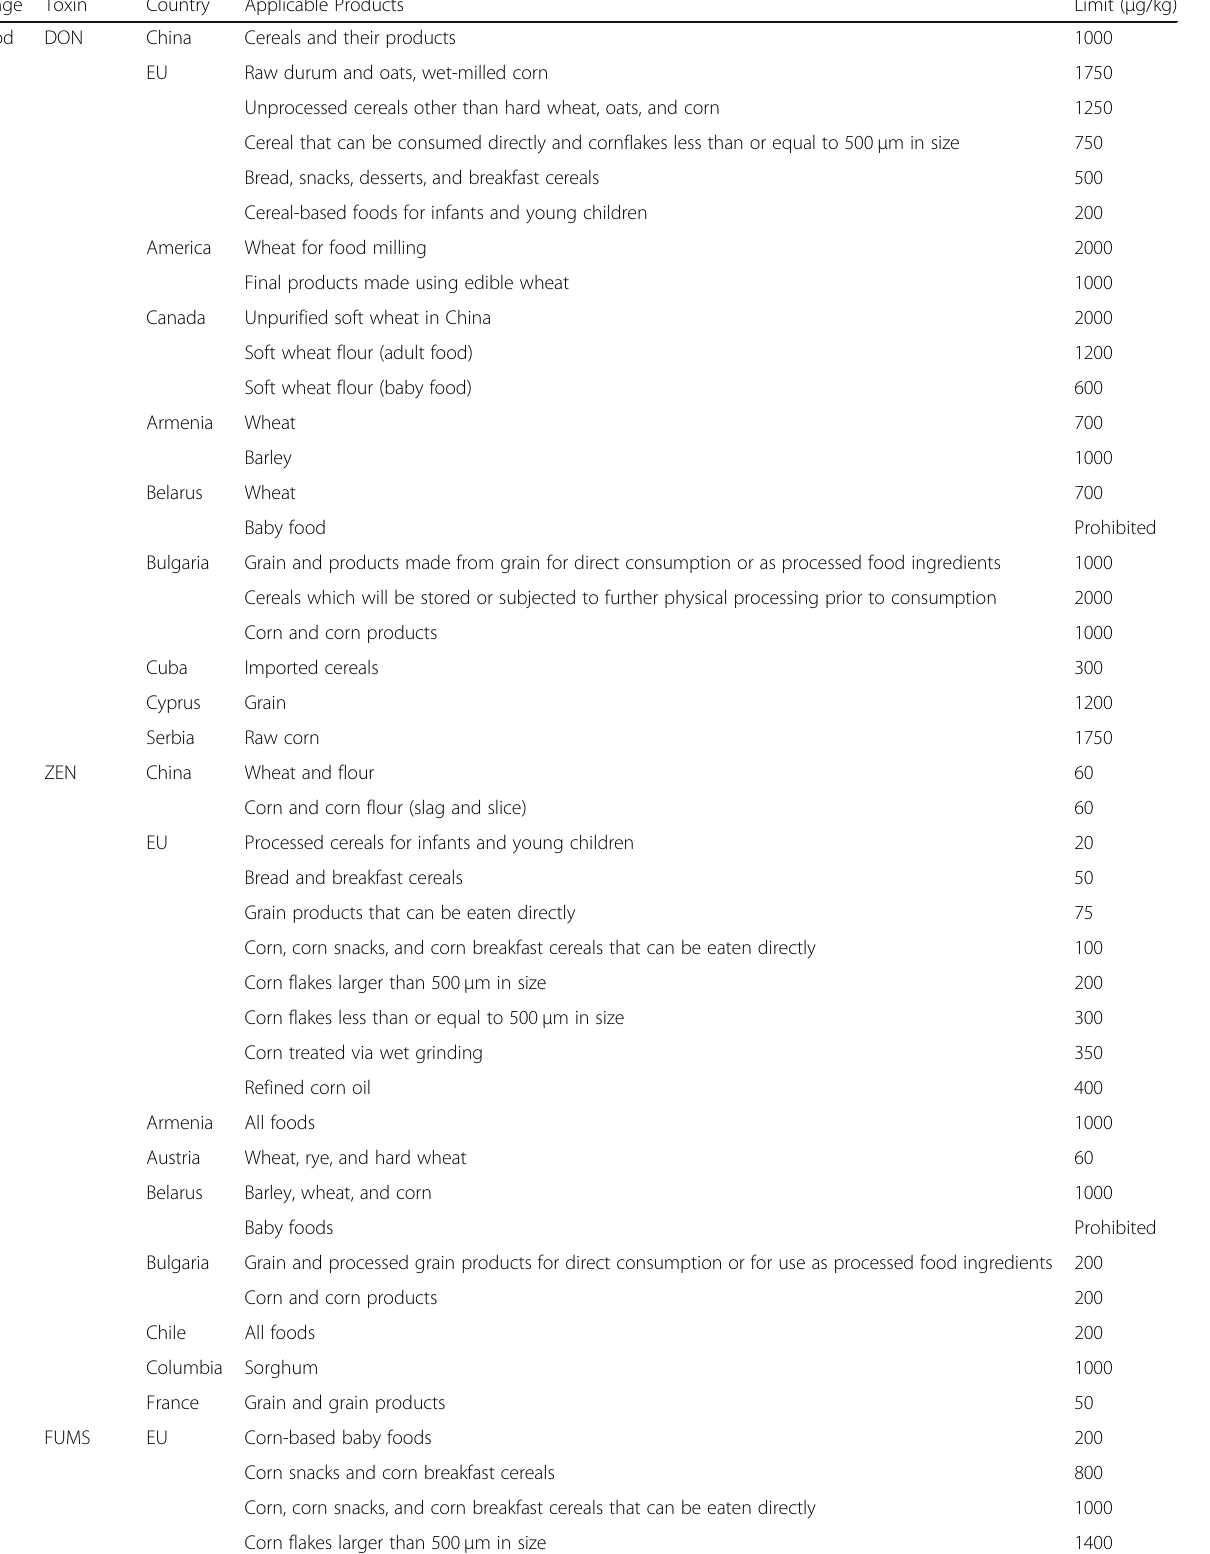
Table 1 Allowable limits of Fusarium mycotoxins in food and feeds in certain countries and regions Range